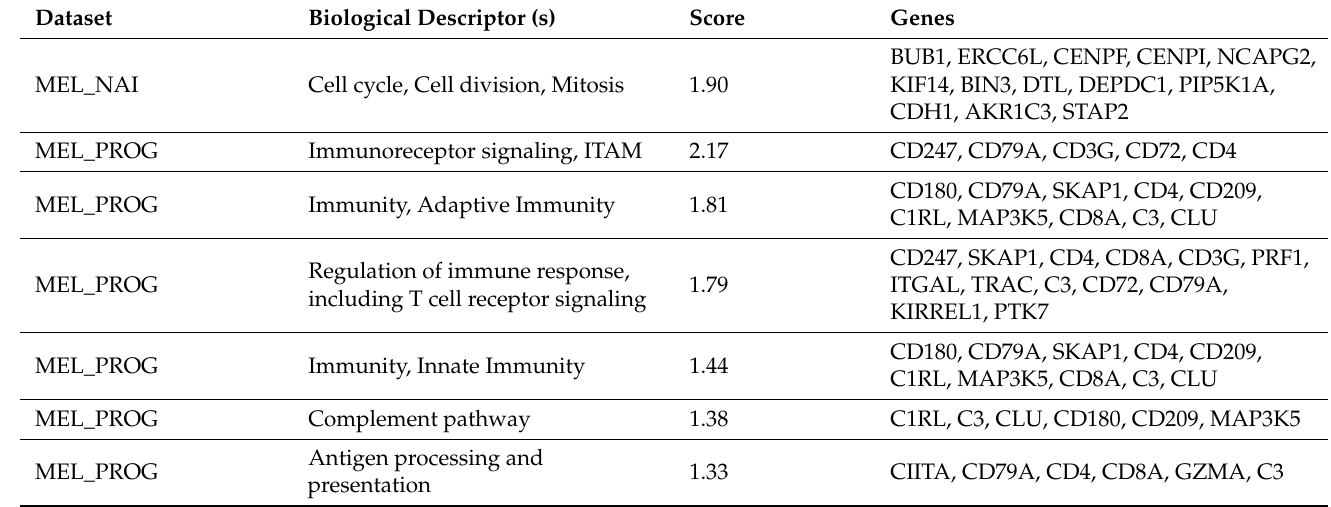
Table 2. Summary of DAVID clusters for immune-regulated, differentially expressed genes in MEL_NAI ( n = 30) and MEL_PROG ( n = 136). Clusters with significant enrichment score ( ≥ 1.3) are